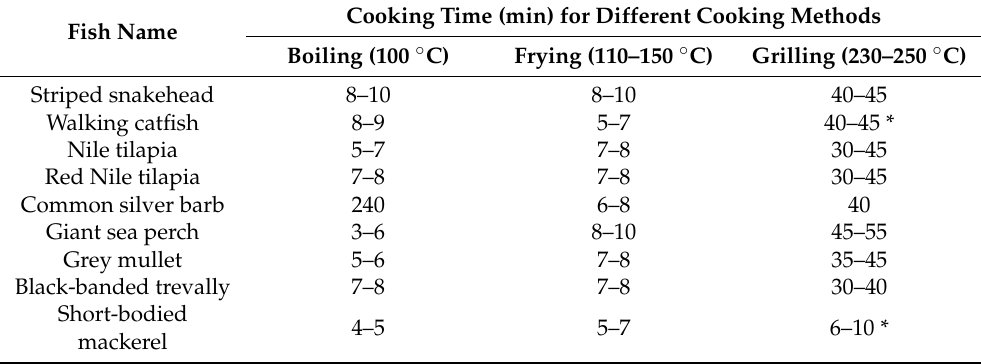
Table 2. Cooking time for three individual sets ( n = 3) of each fish using different cooking